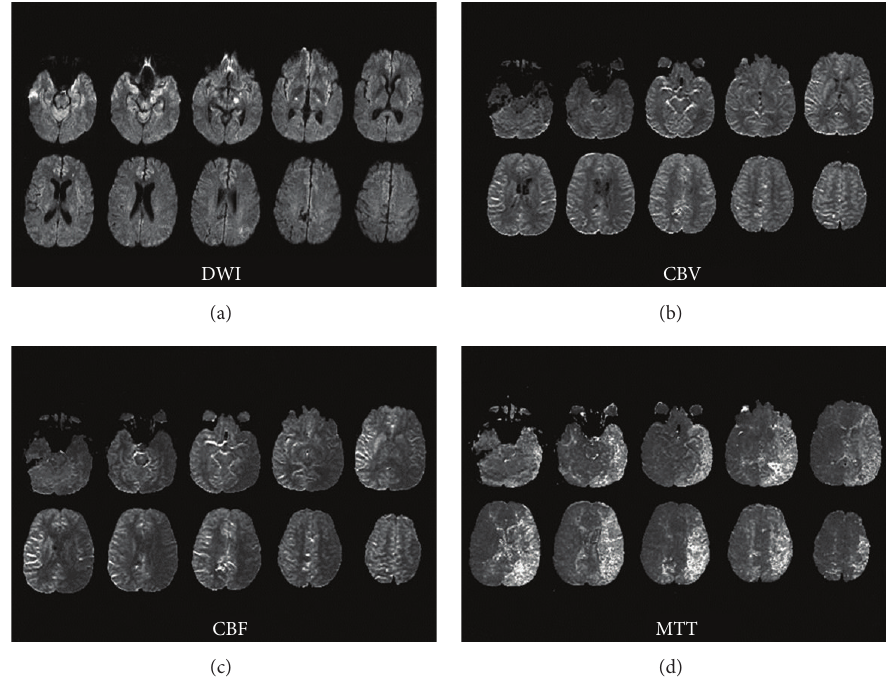
F 11: DWI and MR Perfusion. A patient with severe le-sided and moderate right-sided vasospasm demonstrates diffuse hyperintense signal in the posterior parietal lobe as well as a midbrain lesion on DWI (a), while MR Perfusion shows normal rCBV (b), low rCBF (c), and increased tMTT (d) in the le MCA region. is clearly demonstrates the diffusion-perfusion mismatch phenomenon. Originally published in